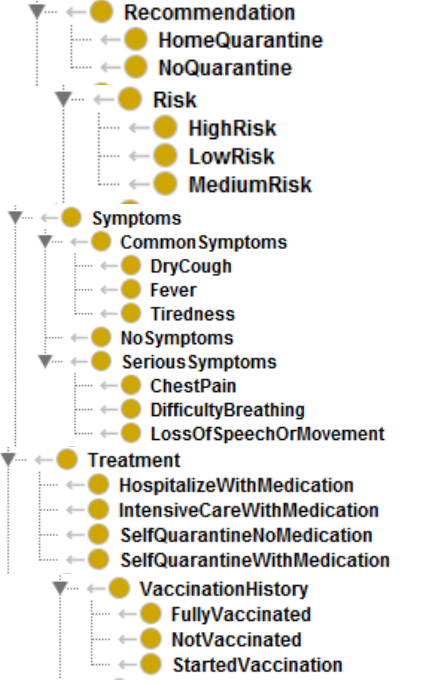
Figure 3. Classes and subclasses hierarchy of the CODCA ontology.